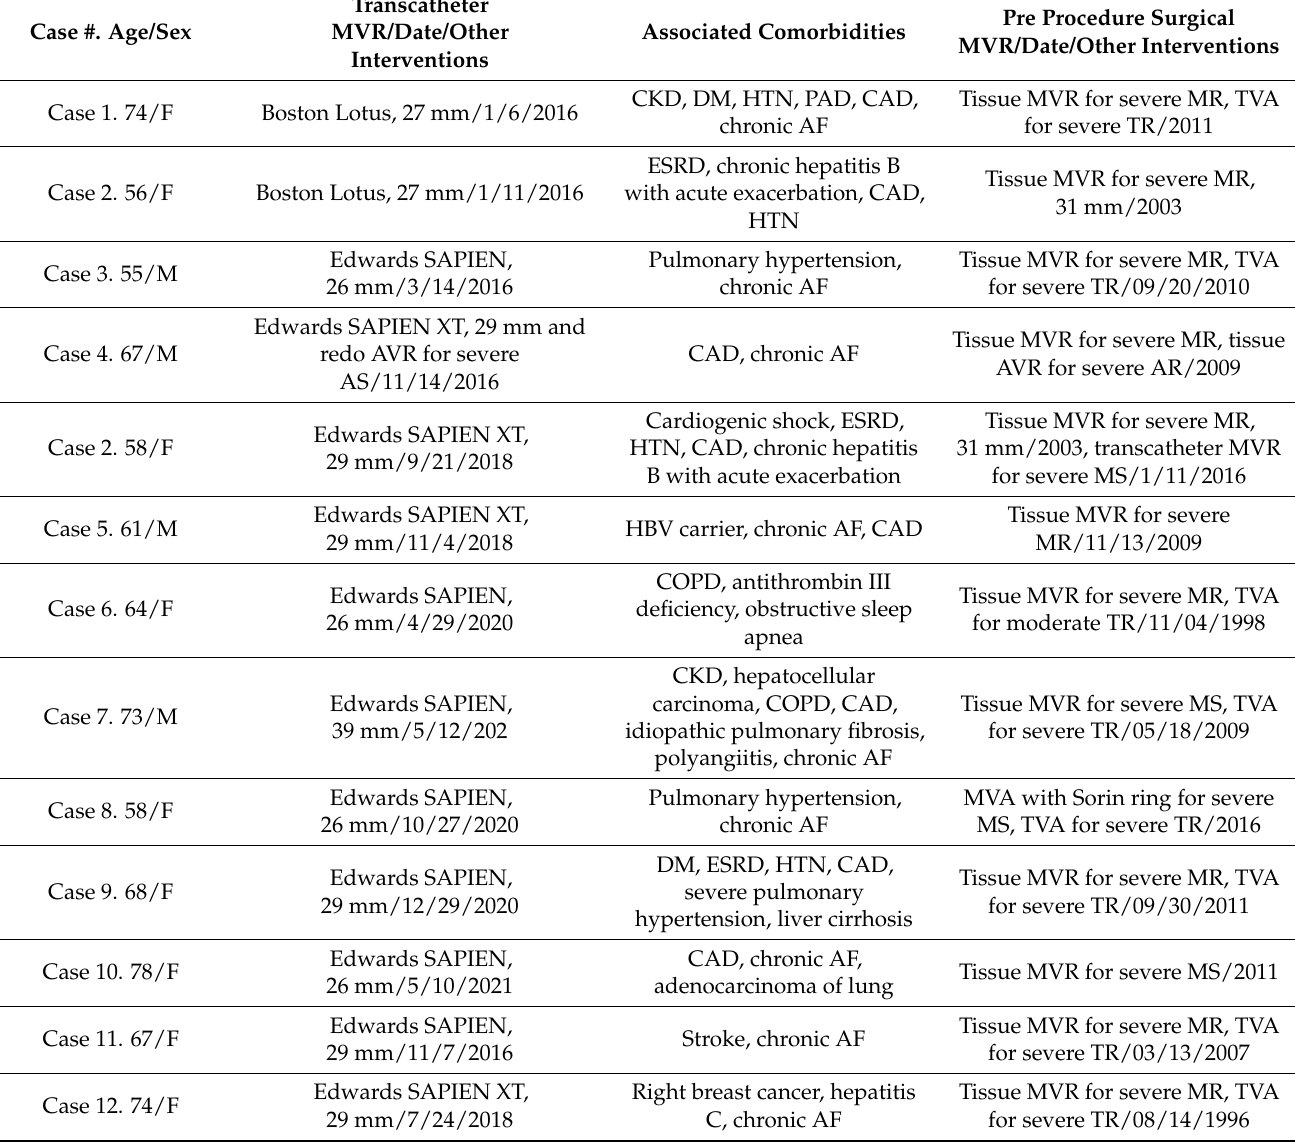
Table 1. Patient